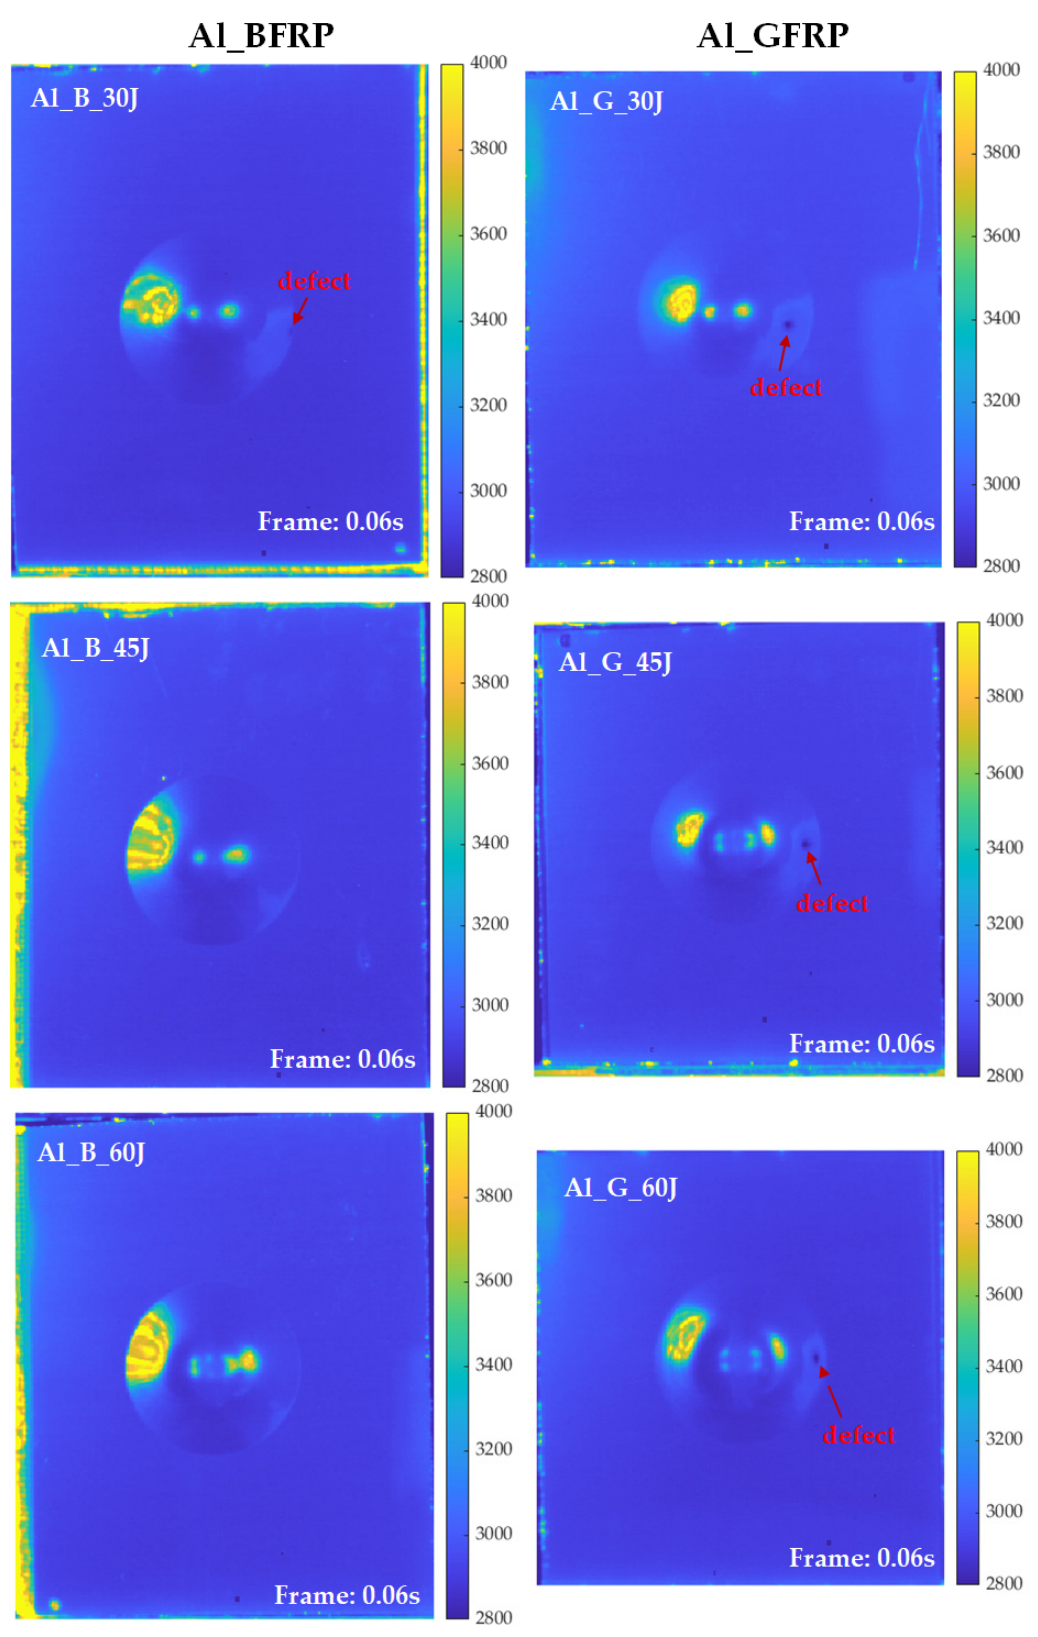
Figure 7. Typical frames from thermal sequences collected from PT experiments on six samples.